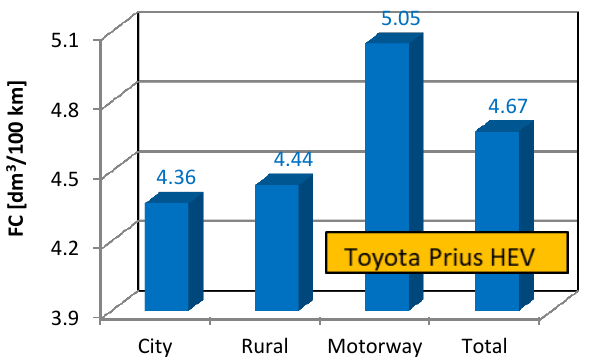
Fig. 6. Fuel consumption in the subsequent phases of the RDE test (Toyota Prius HEV)